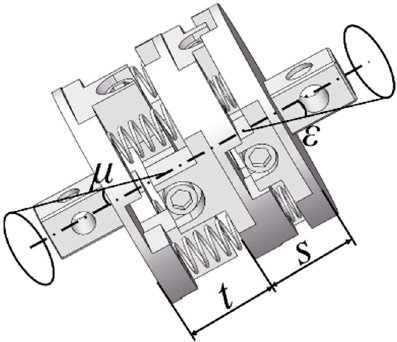
Figure 16. Parameters of the flexible connecting mechanism.